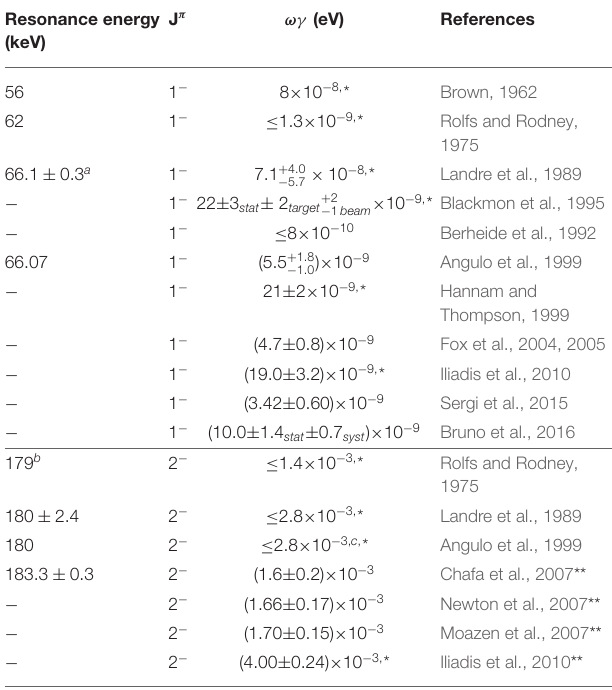
TABLE 1 | Summary table of the strengths of the low-energy resonances in the 17 O( p , α ) 14 N astrophysical